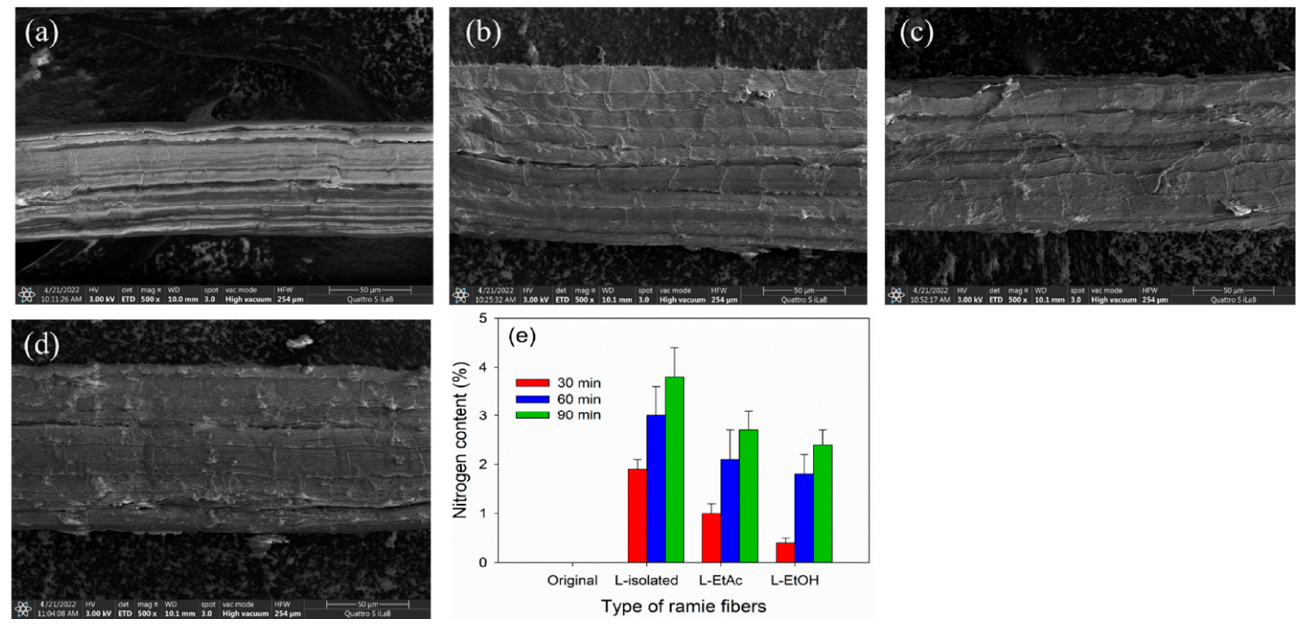
Figure 7. FE-SEM combined with EDX analysis of ramie fibers impregnated with lignin-based PU (LPU) resins: ( a ) original ramie fibers, ( b ) ramie–L-isolated—90 min, ( c ) ramie–L-EtAc—90 min, ( d ) ramie–L-EtOH—90 min, ( e ) nitrogen content of ramie before and after impregnation with different LPU resins for different times. Table 5. Weight gain of ramie fiber after impregnation with lignin-based bio-PU (LPU) resins at different impregnation times.